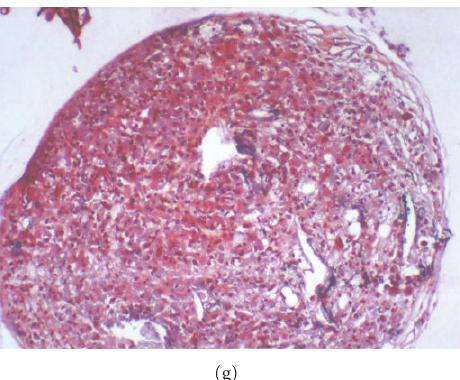
Figure 5: Chondrogenic di ff erentiation. Cells growing in pellet culture system in chondrogenic medium (a, b). Histological section after chondrogenic commitment; UC-MSCs (c) and BM-MSCs (d) stained with Alcian Blue; UC-MSCs (e, f) and BM-MSCs (g) stained with Safranin O (f): higher magnification).